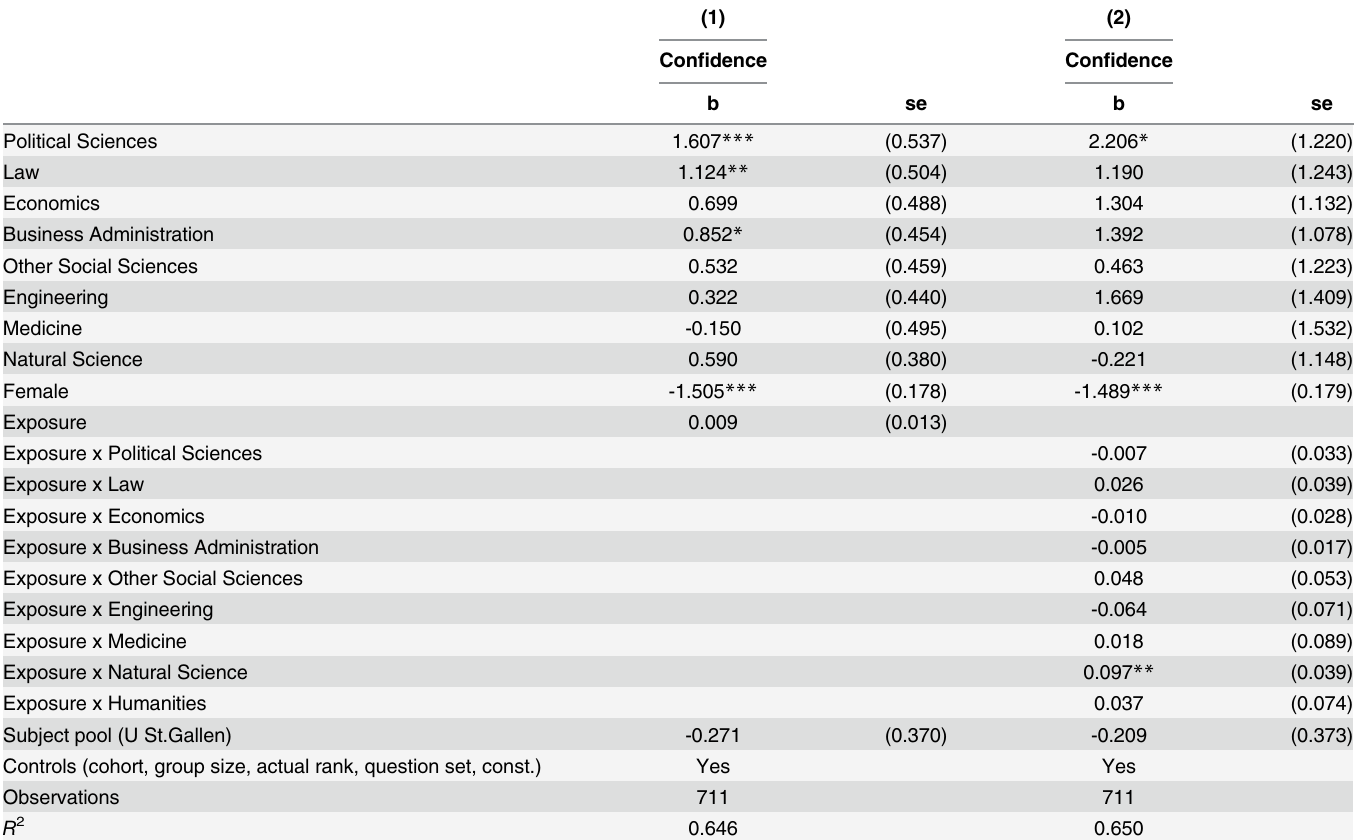
Table 2. Confidence and exposure to field of